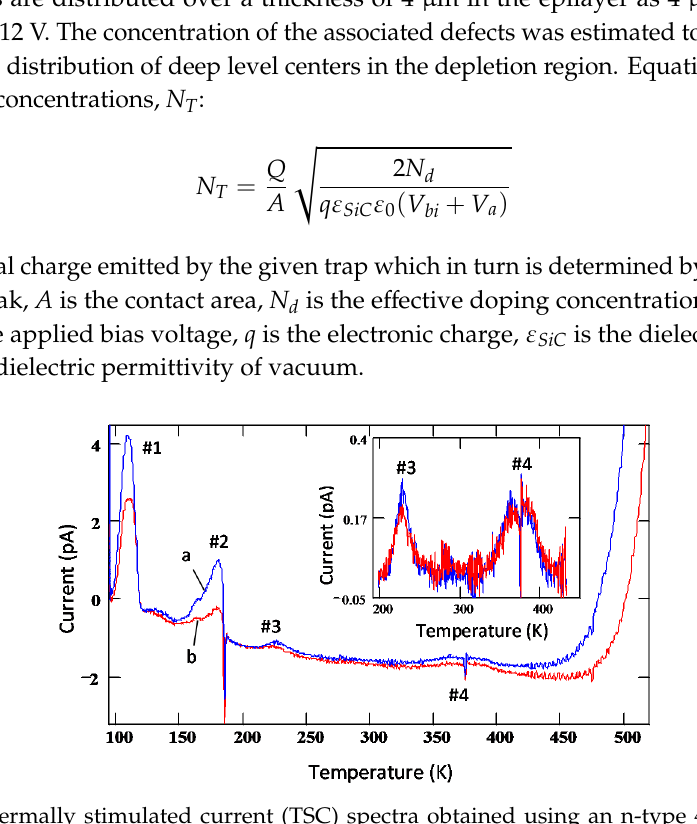
epitaxial layer at two different reverse bias voltages: ( a ) 12 V and ( b ) 4 V.